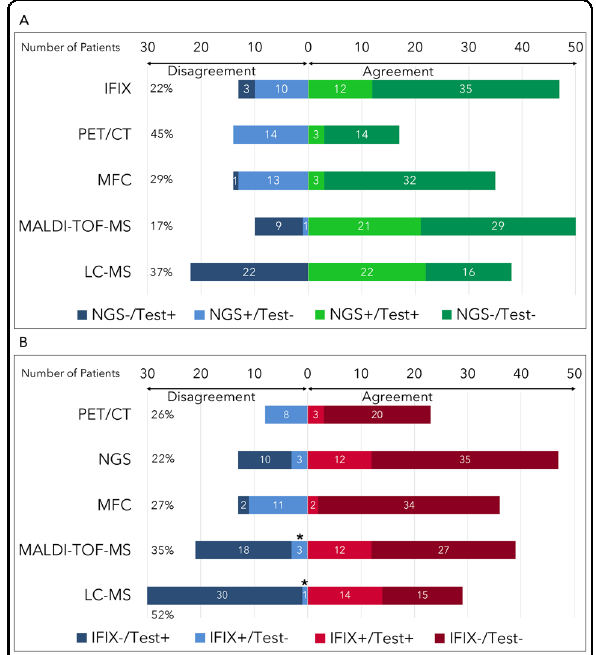
Fig. 1 Dis/agreement among MRD testing methods. A Dis/ agreement between next-generation sequencing (NGS) and other measurable residual disease (MRD) assays. B Dis/agreement between immuno fi xation (IFIX) and MRD assays. *Mass spectrometry (MS) identi fi ed a monoclonal protein of a different isotype from IFIX. LC-MS liquid chromatography mass spectrometry, MALDI-TOF-MS matrix ‐ assisted laser desorption ionization time ‐ of ‐ fl ight, MFC multiparameter fl ow cytometry, PET/CT positron emission tomography/computed